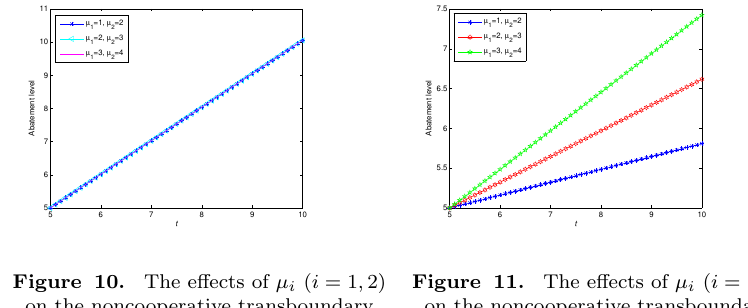
Figure 10. The effects of µ i ( i = 1 , 2) Figure 11. The effects of µ i ( i = 1 , 2) on the noncooperative transboundary on the noncooperative transboundary pollution problems in Wanzhou District’s pollution problems in Kaizhou District’s abatement levels. abatement levels.